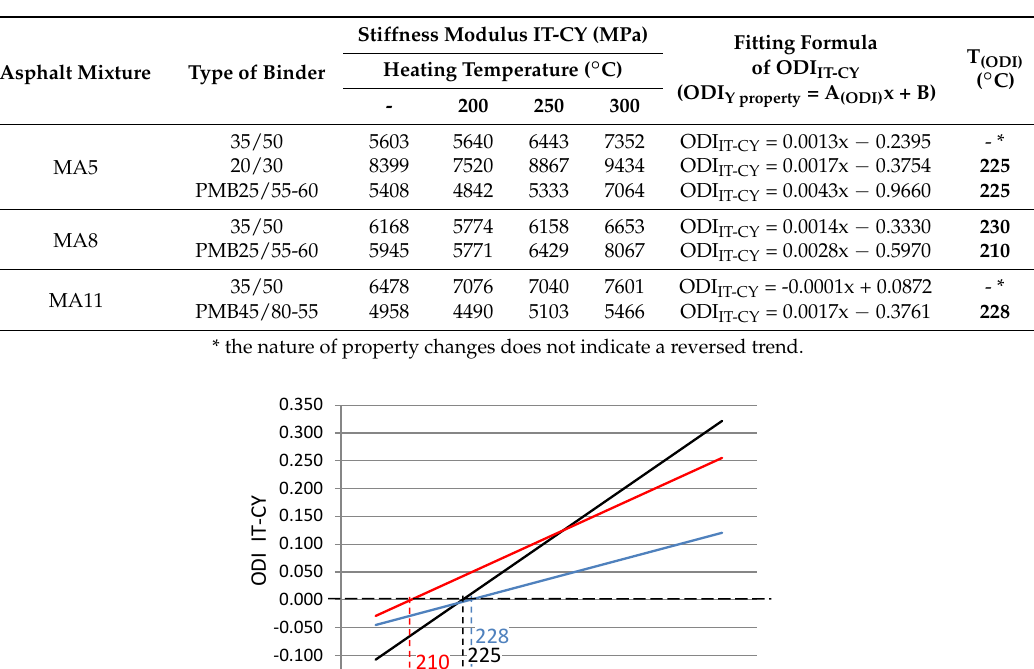
Table 4. IT-CY stiffness modulus and overheating limit temperatures T (ODI) for mastic asphalt with modified and non-modified binders, before and after heating at a high temperature (1 h).